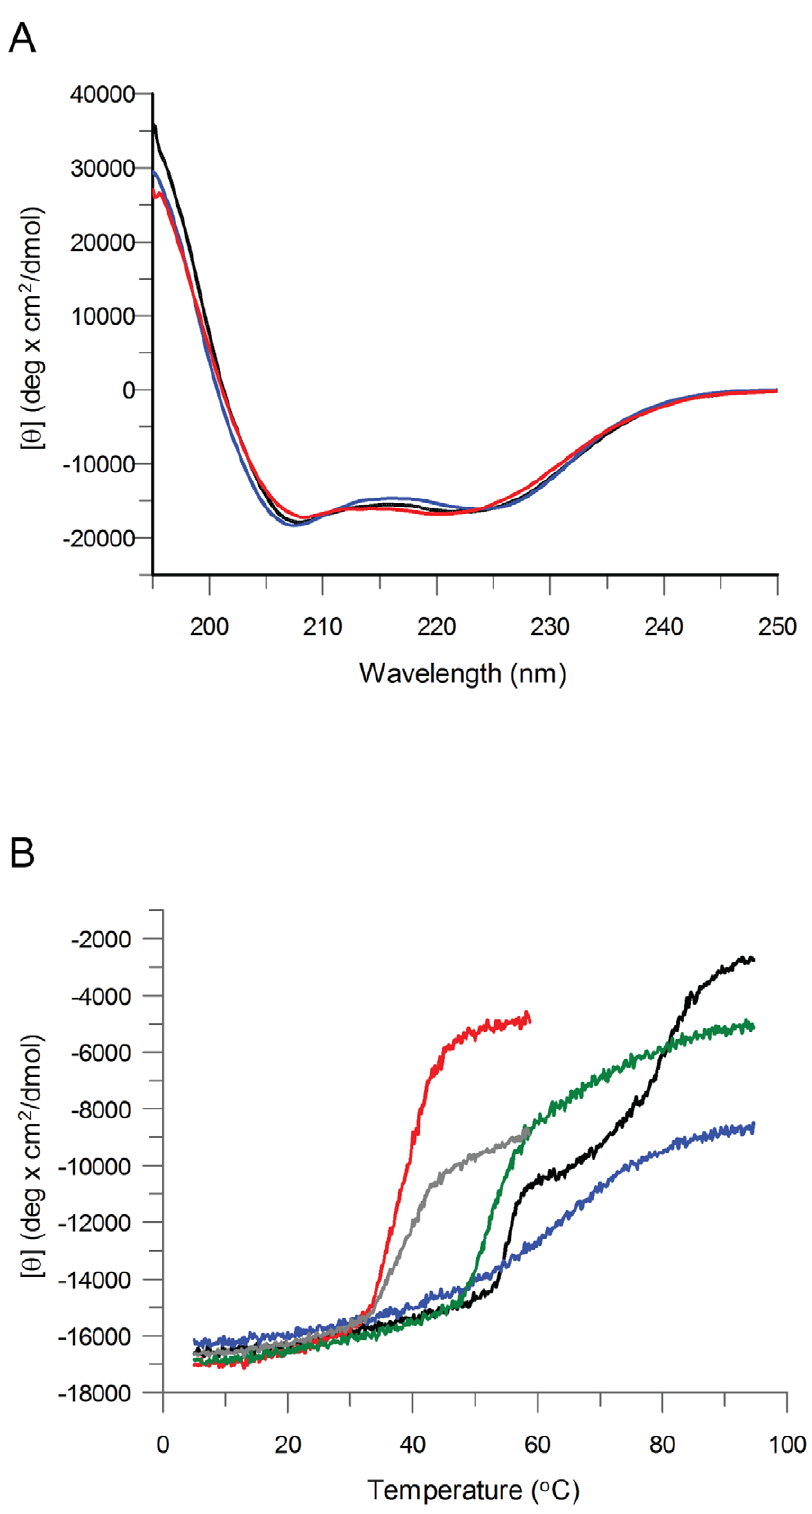
Figure 2. Fold and stability of the CARDs of NOD2. (A) Far-UV CD at 250–195 nm showed highly a -helical proteins as reflected in the double minima at 208 and 222 nm and the strong positive band at 195 nm. Sample concentration was 0.15 mg/ml. The black curve shows the mean residue ellipticity of NOD2-CARDab, the blue curve of NOD2-CARDa and the red curve of NOD2-CARDb. (B) CD thermal unfolding from 5 to 95 u C at 222 nm. Sample concentration was 0.15 mg/ml. A 2 mm cuvette was used. The black curve represents the mean residue ellipticity of NOD2-CARDab, the blue curve of CARDa and the red curve of CARDb. The mixture contained 0.075 mg/ml of NOD2-CARDa and NOD2-CARDb, respectively, and is shown in green. The grey curve represents the computed mean value of NOD2-CARDa and NOD2-CARDb.